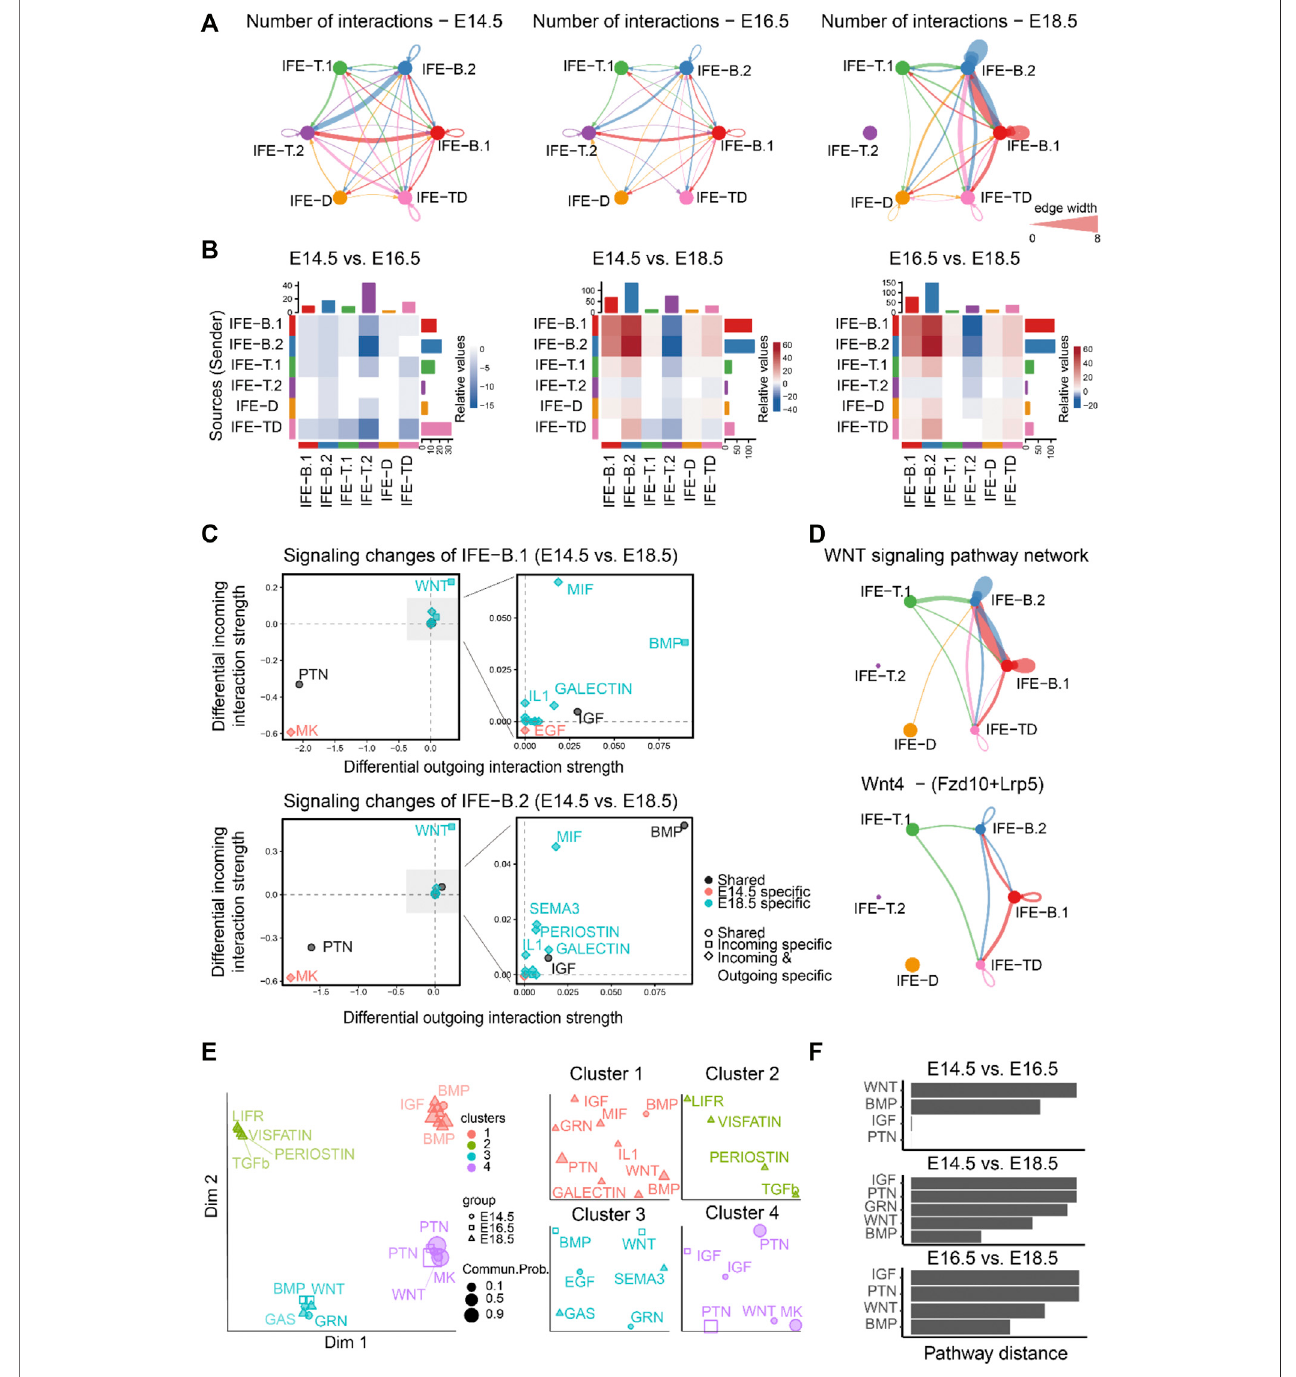
FIGURE 2 | Comparison analysis predicts WNT signaling as a predominant signaling change during mouse embryonic skin development. (A) The comparison of the total number of interactions among different cell populations between E14.5, E16.5, and E18.5. Edge width is proportional to the number of interactions, which assess how many ligand – receptor pairs contributing to the communication between two interacting cell populations. (B) Heatmap showing the differential number of interactions between E14.5, E16.5, and E18.5. In the color bar, red (or blue) represents increased (or decreased) signaling in the second dataset compared to the fi rstone. (C) Identifyingthespeci fi csignalingchangesofIFE-B.1andIFE-B.2fromE14.5toE18.5. (D) TheinferredWNTsignalingpathwaynetworkandWnt4-(Fzd10+ Lrp5) signaling network at E18.5. (E) Projection and classi fi cation of signaling networks from E14.5, E16.5, and E18.5 onto a two-dimensional space based on the networksimilarity.Differentshapesrepresentsignalingnetworksfromdifferentdevelopmentalstages. (F) Computingthepathwaydistanceofthesignalingnetworkfrom E14.5, E16.5, and E18.5 based on their Euclidean distance in the shared two-dimensional space.